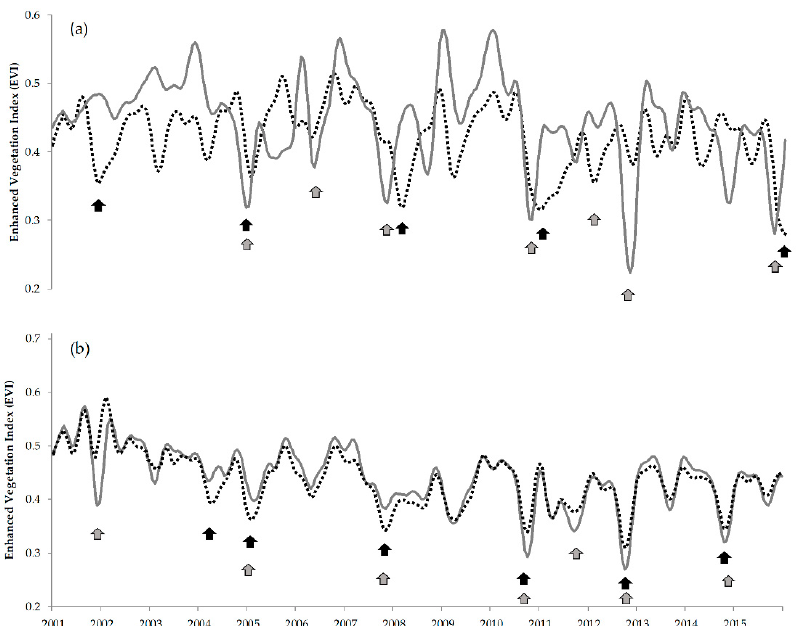
Figure 11. Time series of Enhanced Vegetation Index (EVI) in the Araguaia National Park and Cant ã o State Park, considering: ( a ) Altered Forested Savanna, with five (dotted line) and seven (gray line) years of fire; and ( b ) Grassy-woody Savanna, with six (dotted line) and seven (gray line) years of fire. Arrows indicate the exact dates of fires in these pixels, black arrow for dotted line and gray arrows for the gray